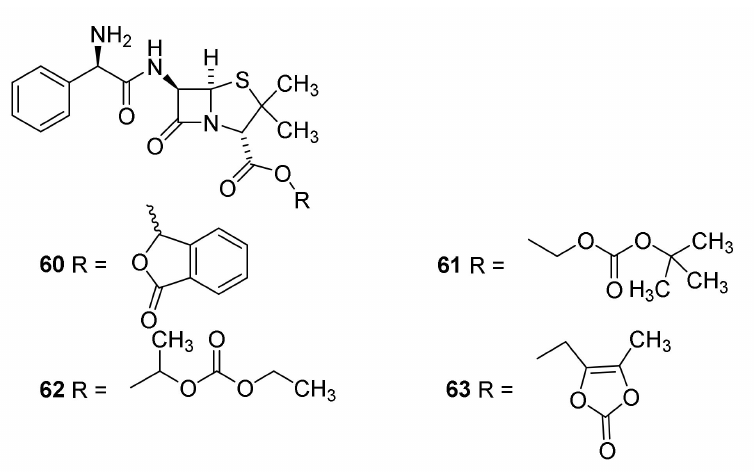
Figure 14. Prodrugs of penicillin: talampicillin ( 60 ), bacampicillin ( 61 ), pivampicillin ( 62 ) and lenampenicillin ( 63 )